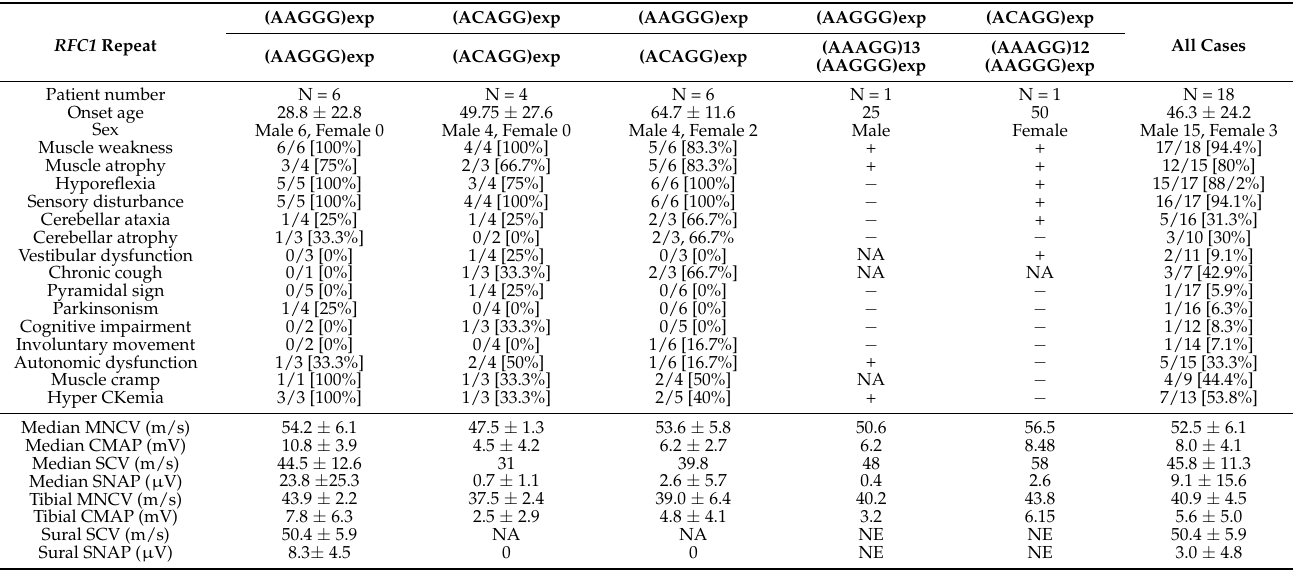
Table 1. Clinical manifestations and electrophysiological findings in 18 cases with RFC1 repeat